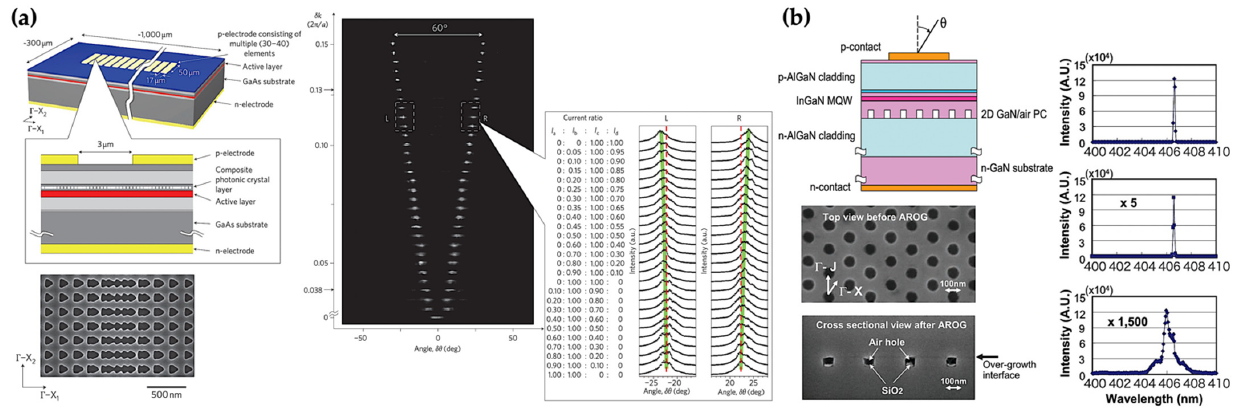
Figure 7. ( a ) Schematic illustration of device structure and the corresponding on-chip beam-steering functionality [55]. The bottom left side of scanning electron microscope (SEM) image shows a portion of fabricated composite photonic crystal with the square and rectangular lattice structures. ( b ) Schematic illustration of the GaN-based photonic-crystal laser device and the corresponding emission spectra above the current threshold [66]. The bottom left side of SEM images show the top view and the cross-sectional view before and after the fabrication of air holes retained overgrowth, respectively. As a result, the well-defined GaN/air periodic structure inside the GaN epitaxial layer can be observed.